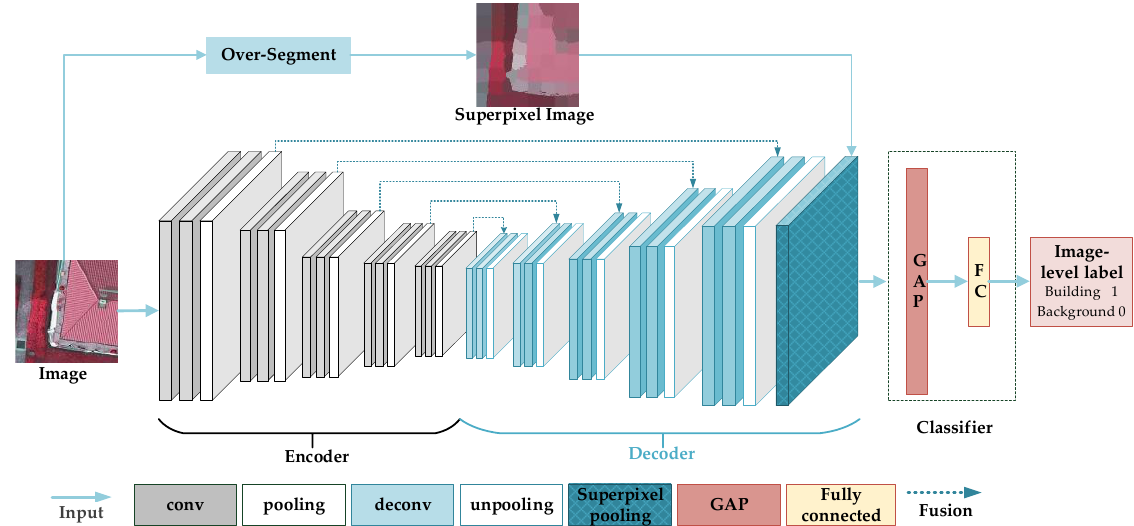
Figure 1. Weak supervision label generation network consists of a downsampling module, a multi- scale upsampling module, a superpixel pooling module, and a